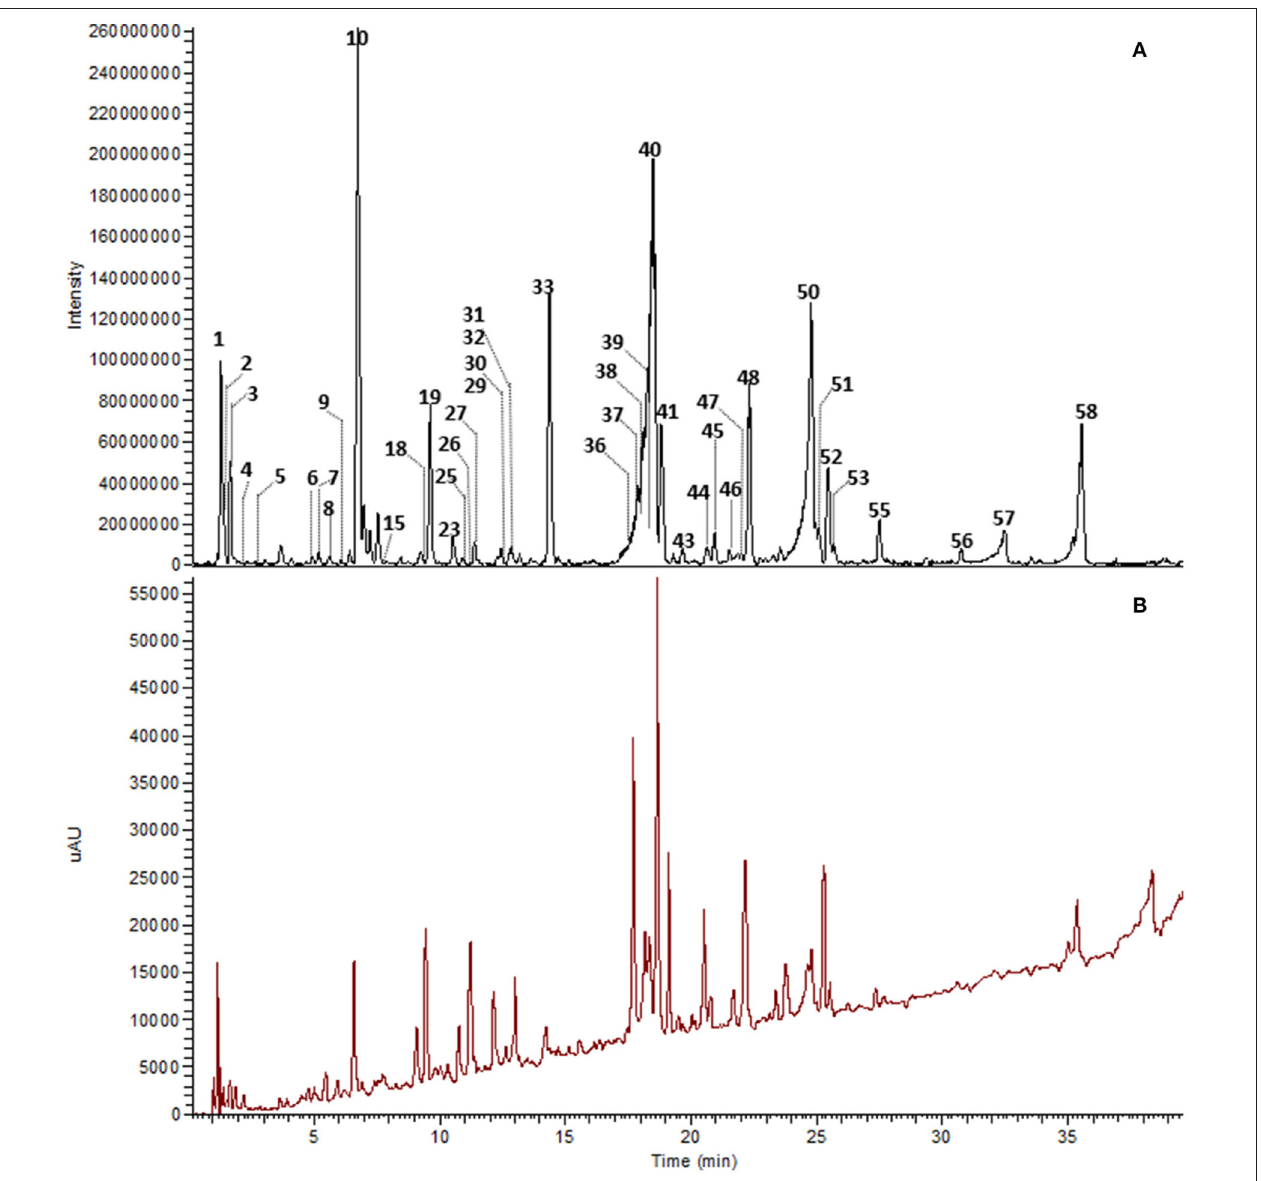
FIGURE 3 | UHPLC-DAD-HRMS chromatogram of WBE (10 mg/ml) in PBS buffer at t0. Peak numbers as indicated in Table 3 and Supplementary Data Sheet 1. (A) Background subtracted base peak chromatogram, ESI negative mode, m/z 100–1500. (B) DAD total scan, 220–400nm.